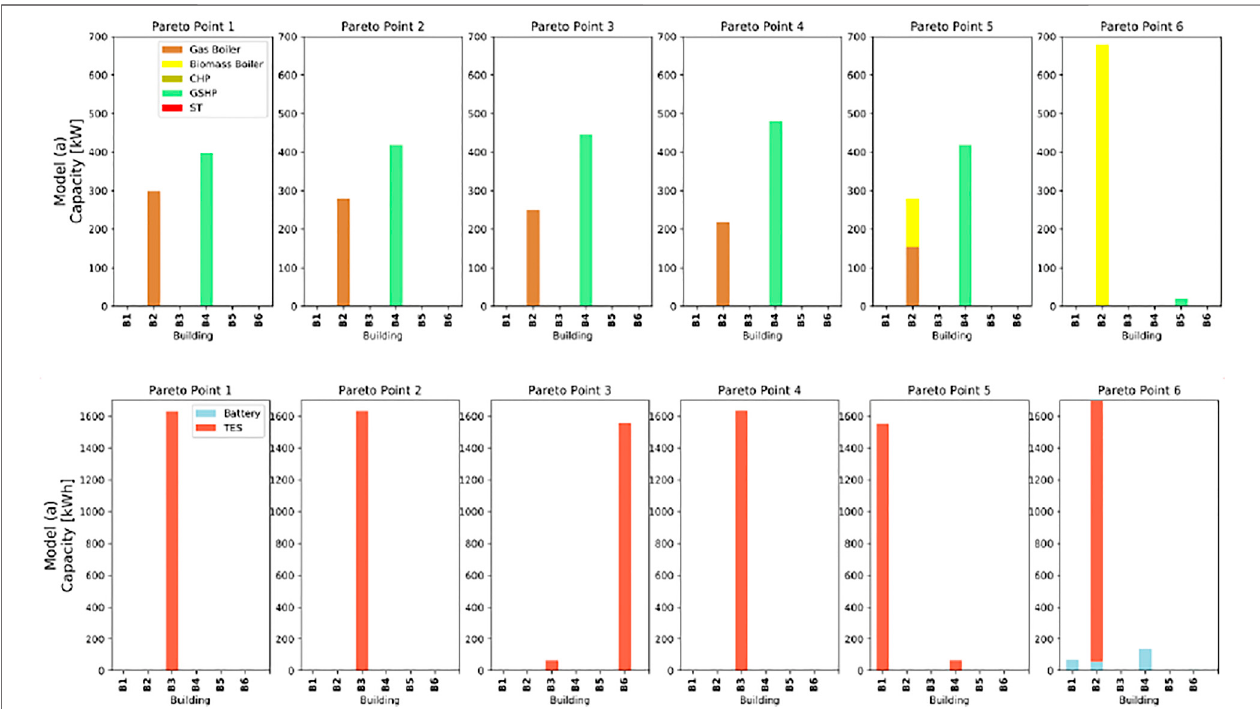
FIGURE 5| Heating technologies (top) and storage technologies (bottom) size installed at each buildingfor all Pareto optimal solutions.As here, the main focus is thecomparisonofthethermalnetworkdesignandperformancesfrombothmodels.Detailedresultsofsystem-leveldesignandanalysisofothertechnologiesarefurther discussed in Results and discussion for optimization model comparison